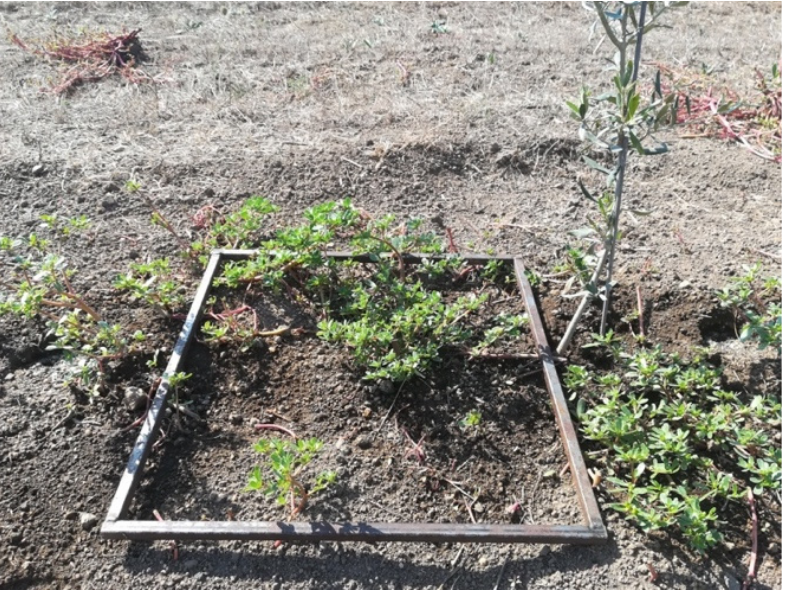
Figure 3. Weed emergence and soil coverage in GK 1.2 forward speed treatment in September 2020. New weeds are limited to the wet area below the drip irrigation.